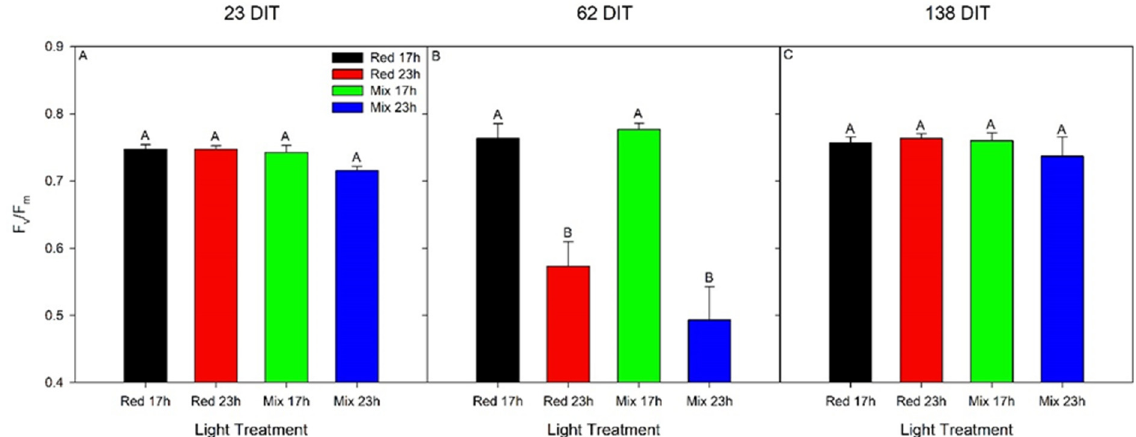
Figure 3. Maximum efficiency of PSII (F v /F m ) from the 5th leaf of TE tomatoes grown under red 17 h, red 23 h, mix 17 h, or mix 23 h lighting treatments at 23 DIT (December 8, 2018, panel A ), 62 DIT (January 16, panel B ), and 138 DIT (April 2, 2019, panel C ). Error bars represent the standard error of the mean of n = 8. Letter groups (A, B) represent significant differences between the lighting treatments at a specific time point and leaf position at p < 0.05.